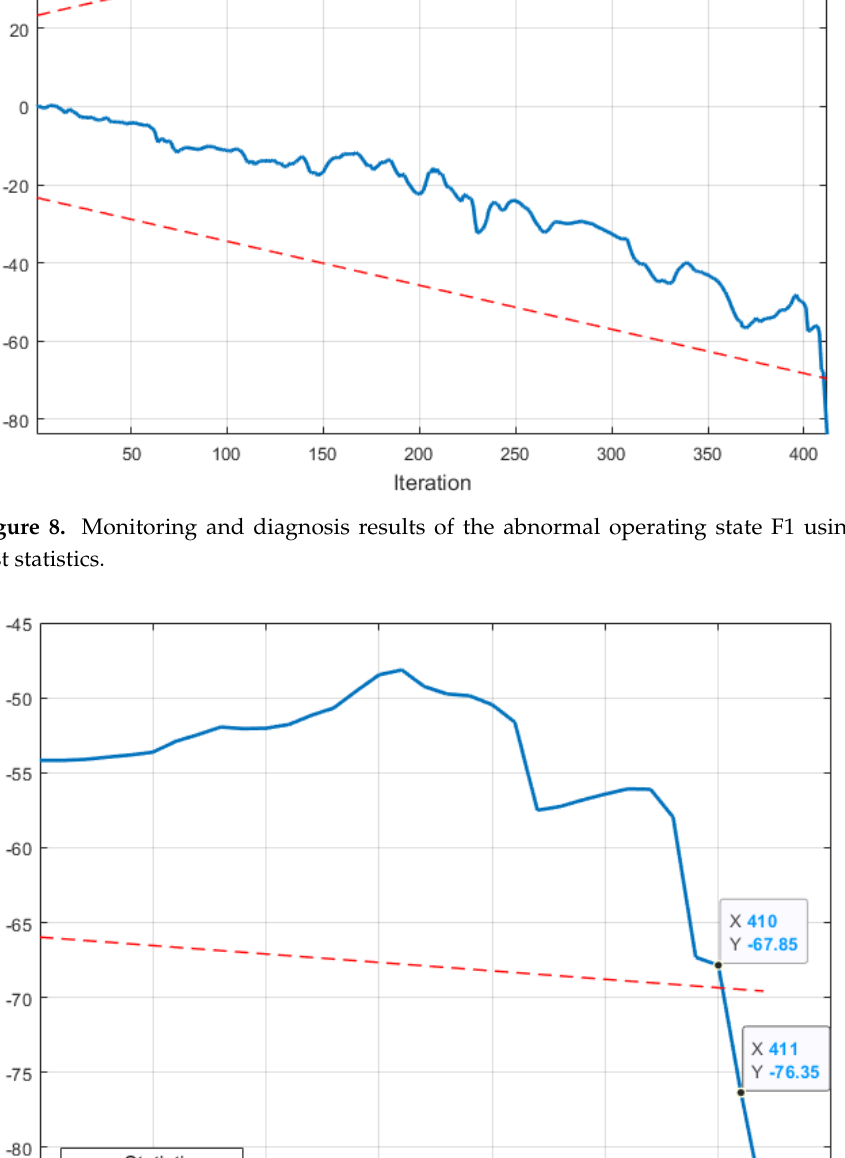
Figure 10. Monitoring and diagnosis results of the gearbox fault F2 using CUSUM test statistics.